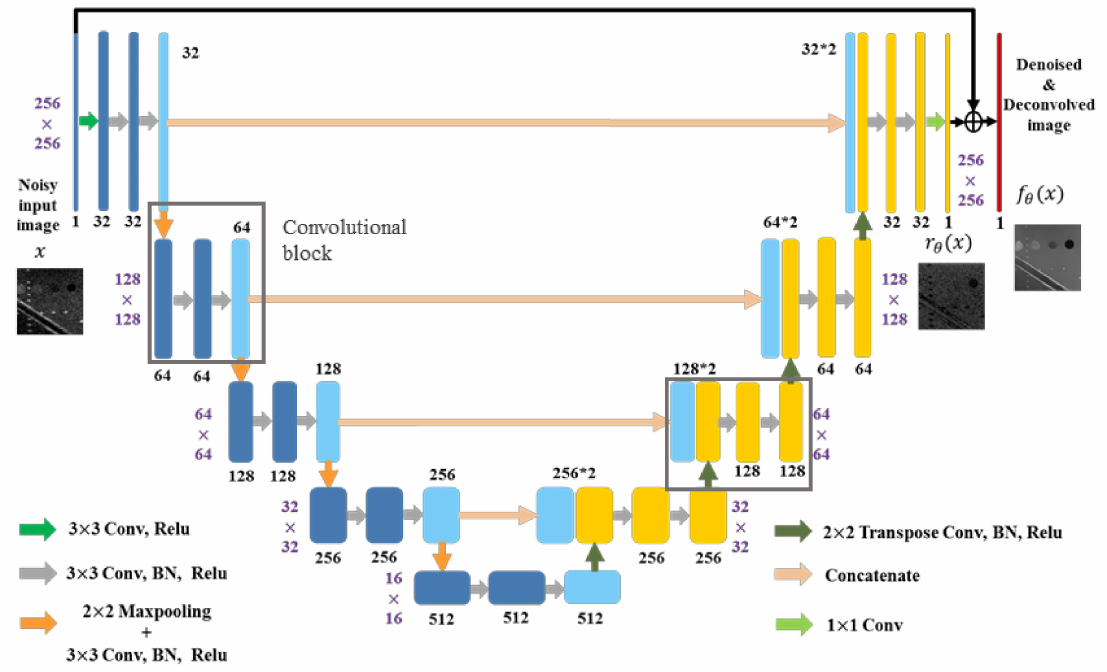
Figure 3. The proposed network